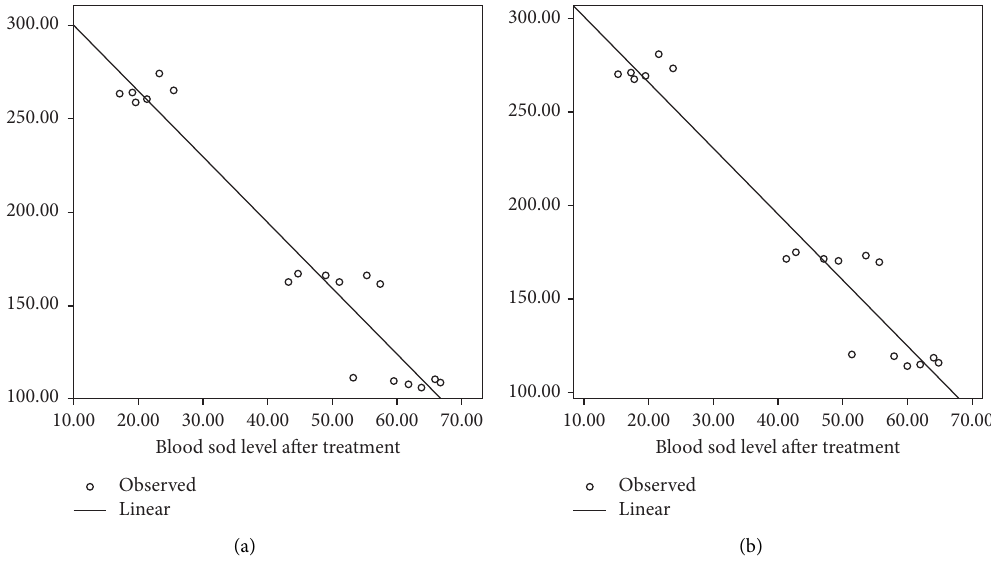
Figure 5: Correlation of (a) SOD vs. fasting diabetic glucose and (b) SOD vs. postprandial diabetic